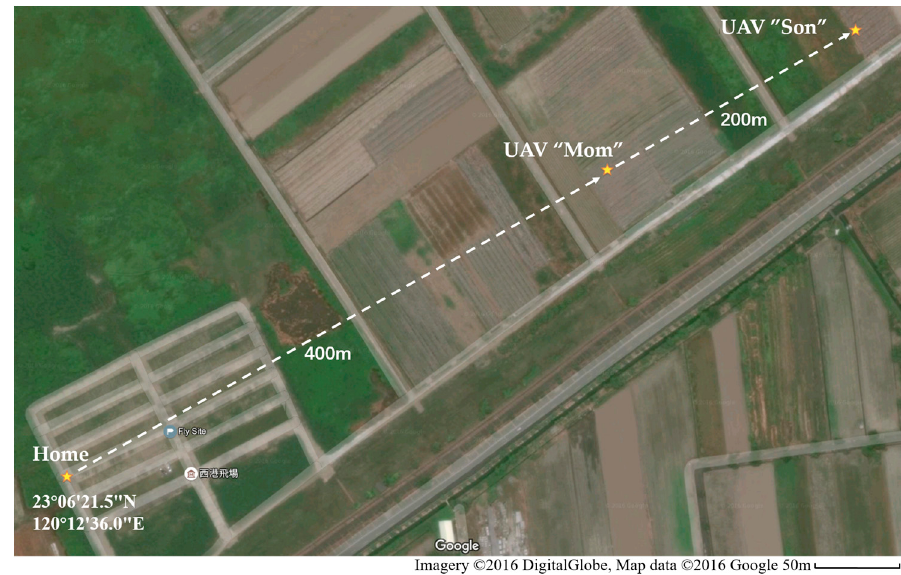
Figure 21. Final positions of nodes in the Google map in the extended distance test in Taiwan.